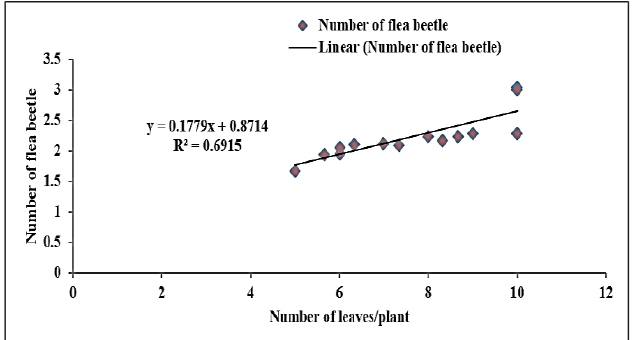
Figure 2: Relationship between the population of flea beetle and number of leaves/plant